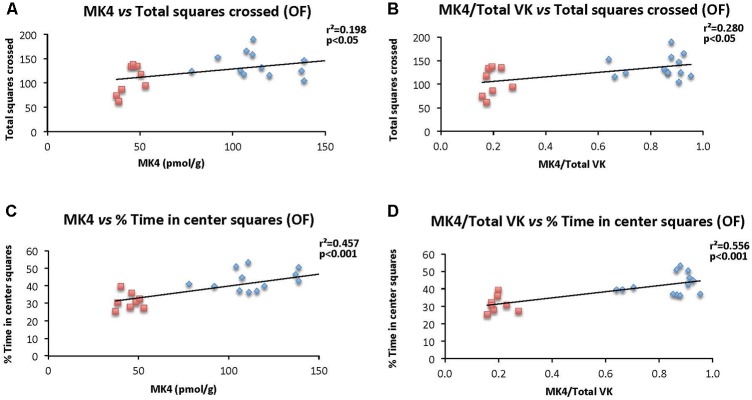
Relationship between brain MK-4 and locomotor activity and exploratory behavior. Figures show relationships of (A) MK-4 vs. total squares crossed; (B) MK-4/total VK vs. total squares crossed; (C) MK-4 vs. % time in central squares (OF); (D) MK-4/total VK vs. % time in central squares (OF). Data were analyzed by Pearson correlation test, n = 14–21 rats per correlation. Statistically significant, p < 0.05.